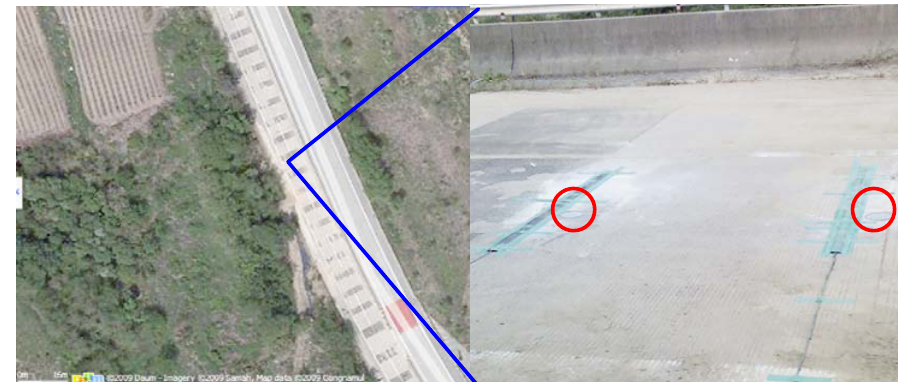
Figure 9. Old highway testbed. (a) Old highway testbed and deployed switching tape and two T-Sensor-v nodes (red circles). (b) Eight vehicles among the nine vehicles used on 12 Oct. in 2007. (c) Four vehicles used on 13 Oct. in